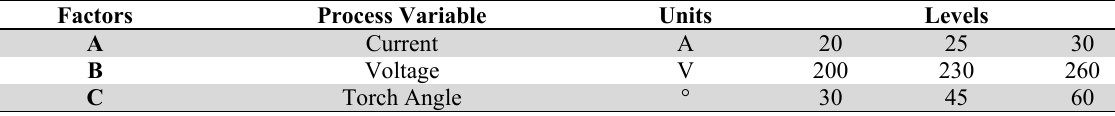
Levels of input welding parameters